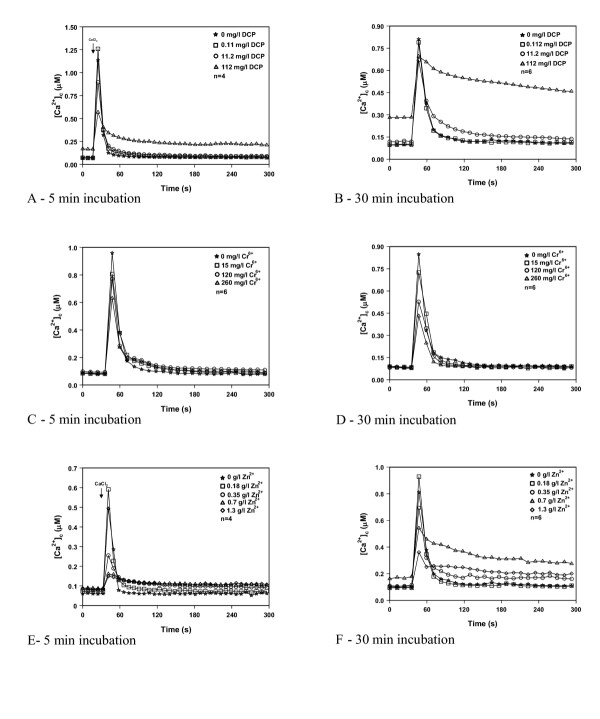
Effect of 3,5-DCP, Cr6+ and Zn2+ on [Ca2+]c response to the addition of external CaCl2 (5 mM). A, C and E show 5 min incubation with the toxicant, B, D F show 30 min incubation with the toxicant.